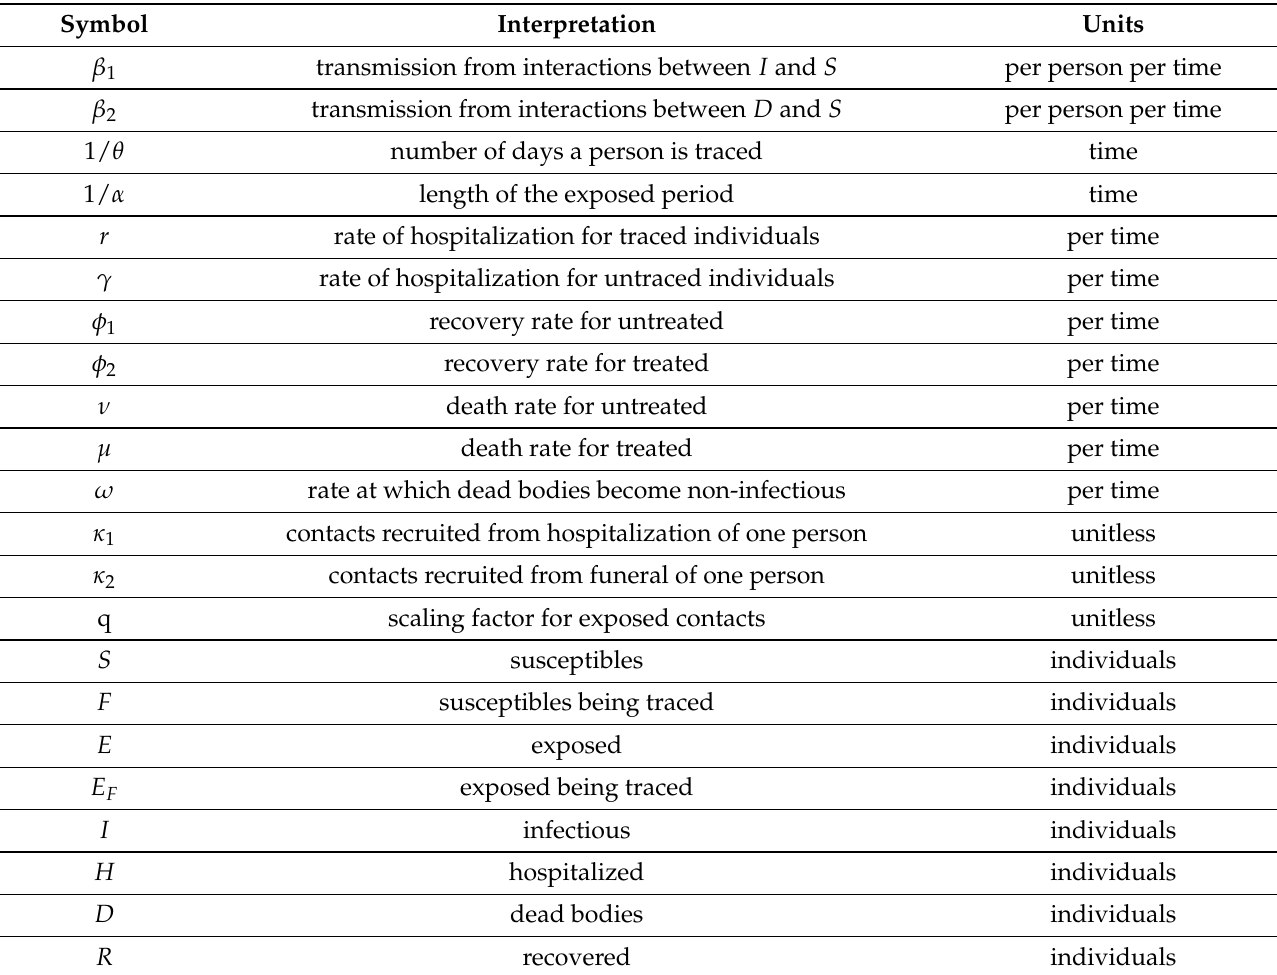
Figure 1. Flow diagram with Susceptible–Exposed–Infectious–Recovered ( SEIR ) standard disease compartments, F , E F compartments due to contact tracing, and H , D for Hospitalized and Dead bodies as appropriate for Ebola. The coefficient f represents transitions due to contact tracing. The parameters and compartments are defined in Table 1. Table 1. The parameters and compartment names in our model with their interpretations and